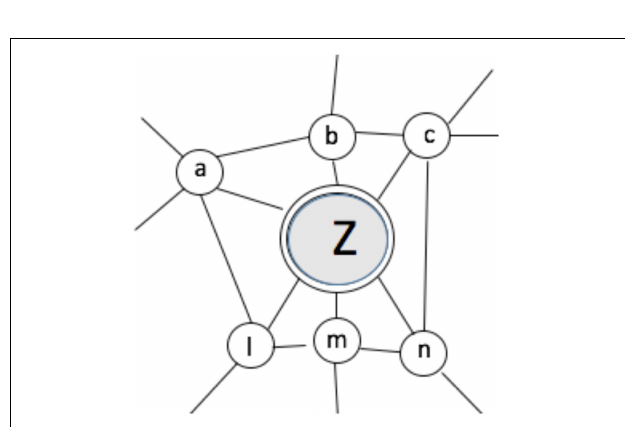
FIGURE 8 | Accessing contents of packet Z requires sustained attention in the associative neighborhood until effort is mounted sufficient for overcoming “resistance”(i.e., boundary energy barrier) (adopted from James, 1950/1890, v. 1, p.